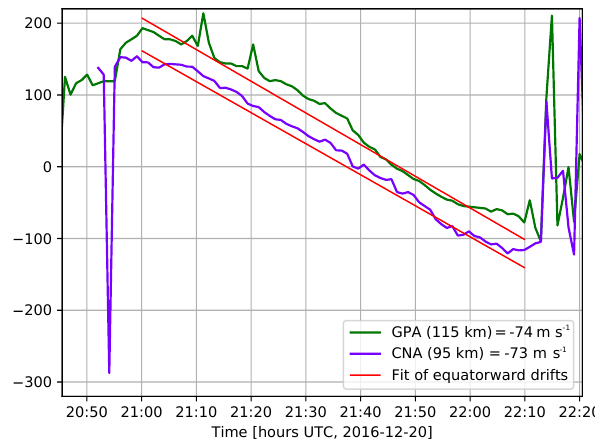
Figure 4. Position of the strongest optical emission of the growth- phase arc (GPA) and cosmic-noise absorption (CNA) projected onto a common plane as a function of time. Fitted lines demonstrate the linear equatorward drift during the growth phase. The time range is the same as in Fig. 3.